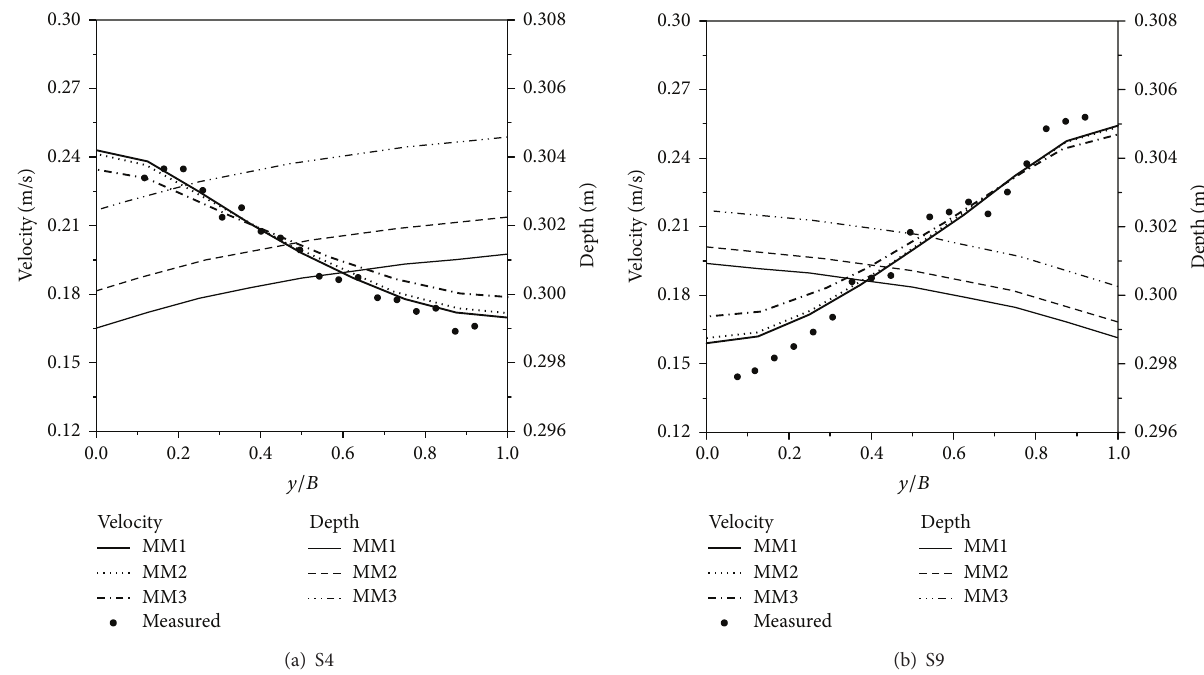
Figure 3: Velocity and depth distributions of the meandering channel flow according to varying Manning coefficients. Table 3: Simulation conditions for meandering channel